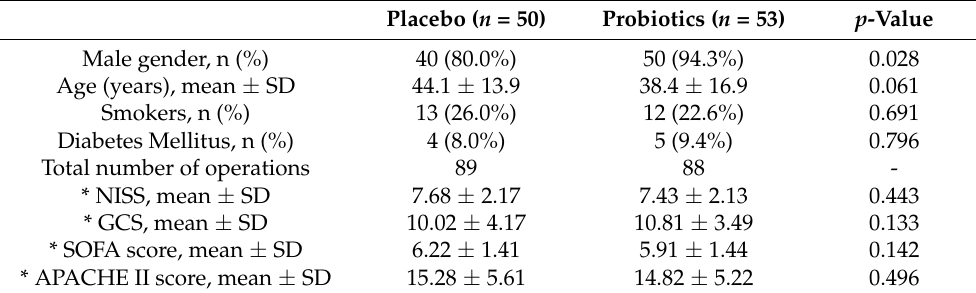
Table 1. Demographic data.